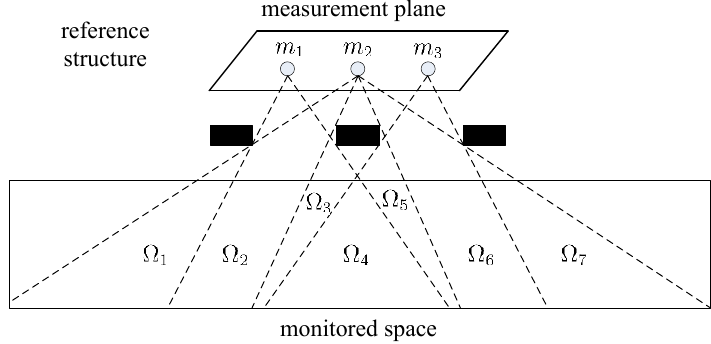
Figure 1. Our sensing model: reference structure, measurement plane, monitored space. Ω 1 ... Ω 7 are sampling cells. Each sampling cell has the same visibility to the sensor